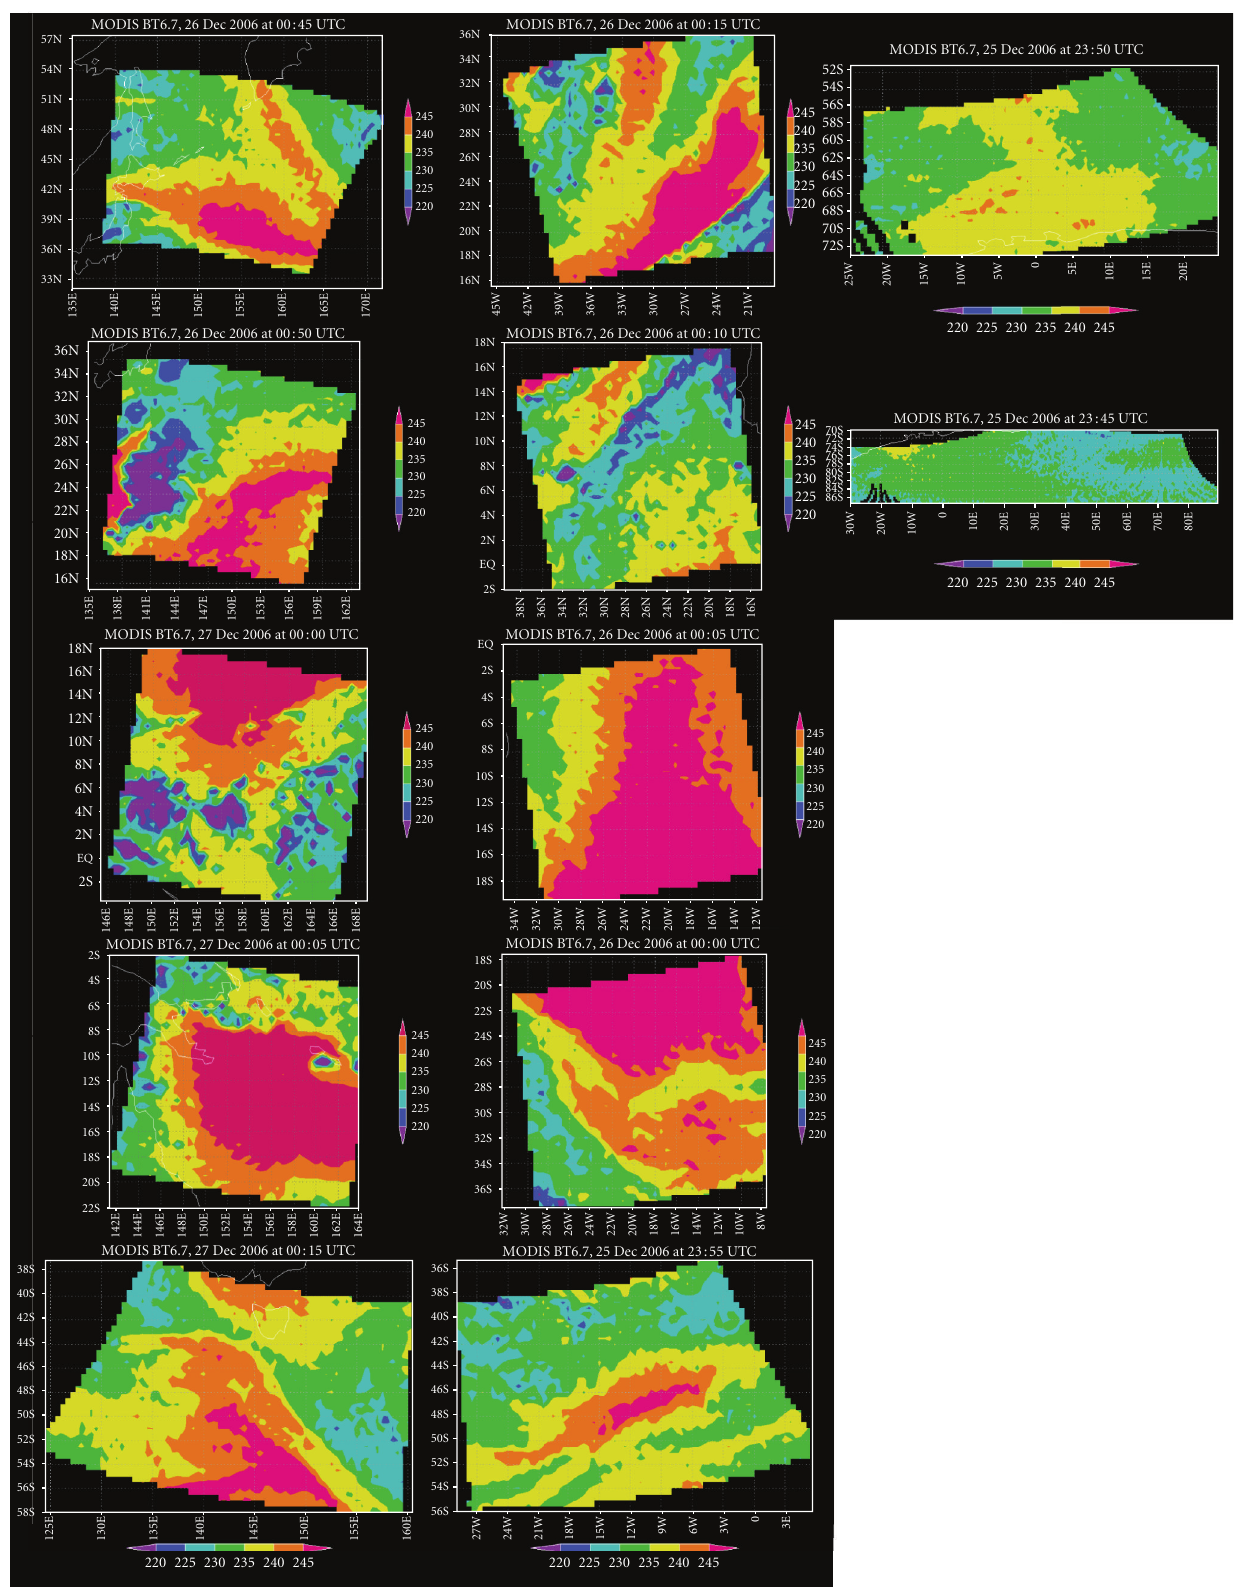
Figure 1: Brightness temperature at 6.7 μ m wavelength (BT6.7) in K, representing the upper tropospheric brightness temperature (UTBT) of MODIS scenes above the Pacific ocean (1st column) and the Atlantic ocean (2nd and 3rd